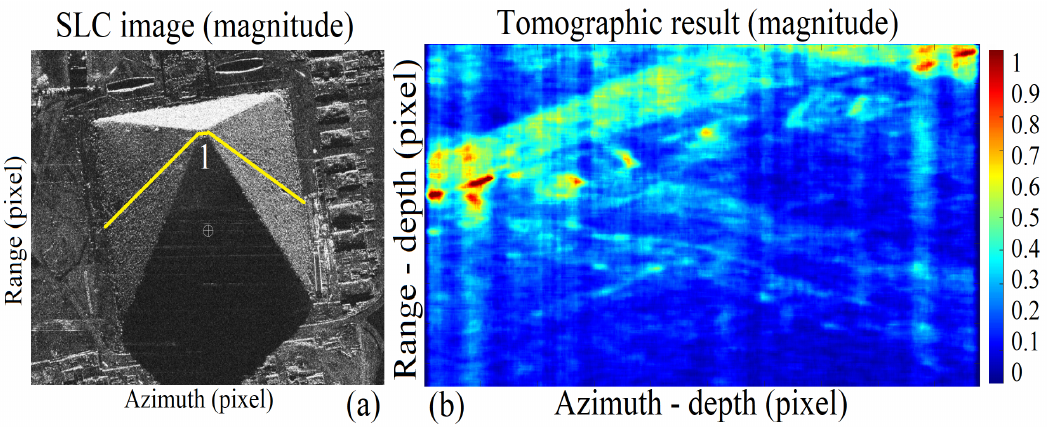
Figure 37. SAR images. ( a ): SLC SAR image (magnitude). The tomographic line 1 is oriented along the Northern-Southern-sides of the pyramid. ( b ): Tomographic result